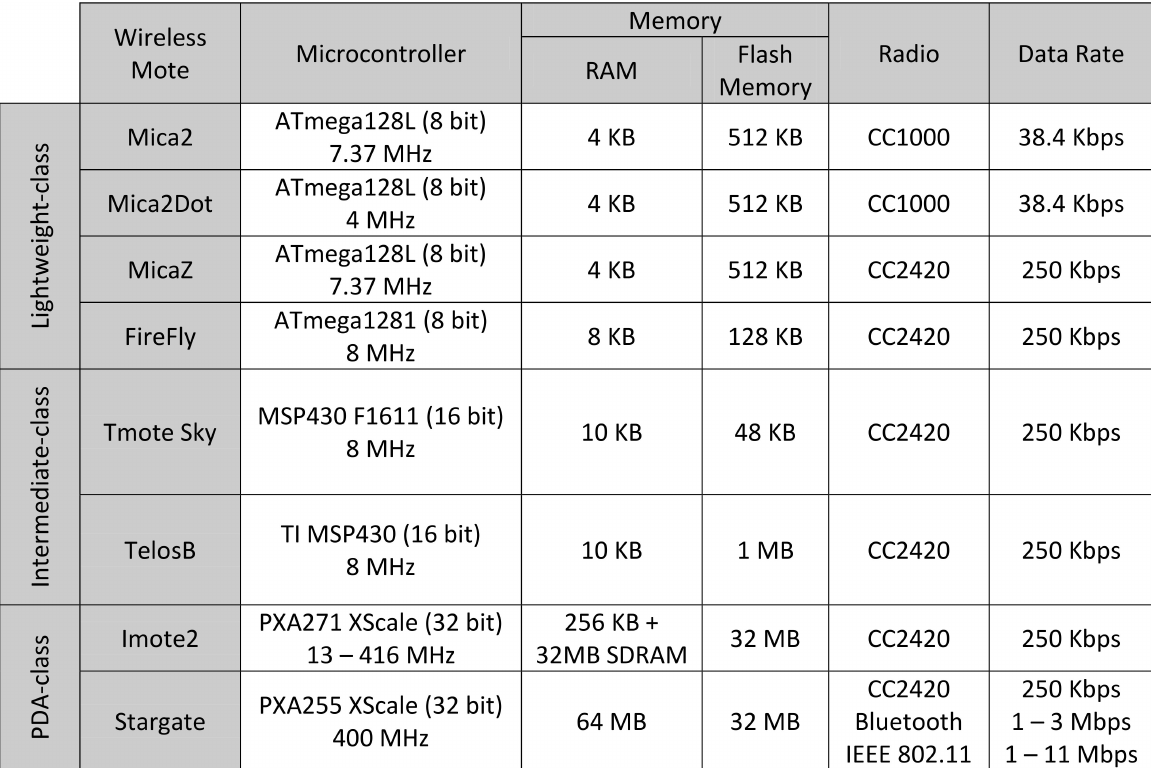
Table 4. Comparison of the Features of Wireless